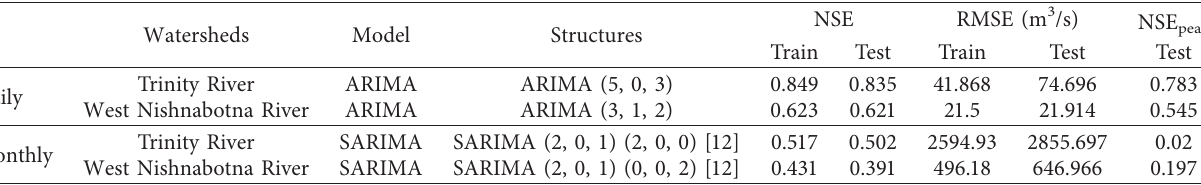
Table 7: Performance results of ARIMA and SARIMA